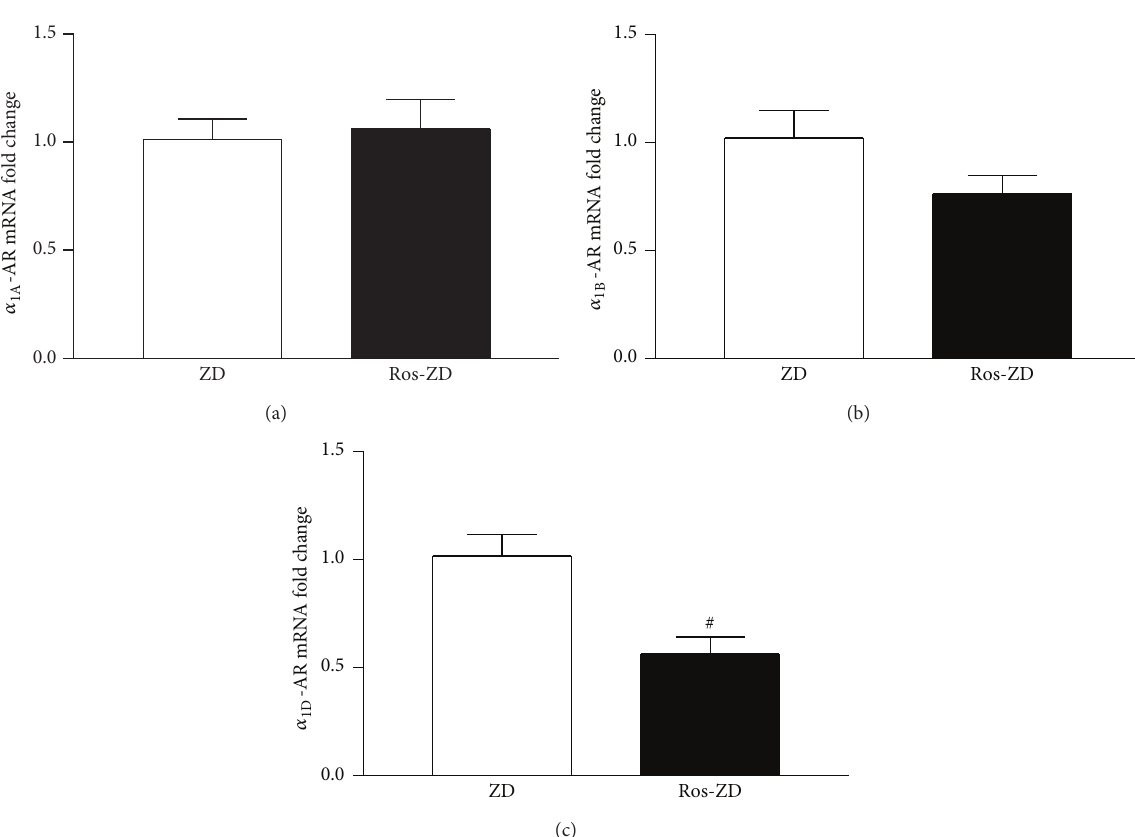
Figure 2: Effect of PPAR 𝛾 activationon renal expression of 𝛼 1 results of renal cortical 𝛼 1 Values are mean ± SEM. 𝑛 = 5 - 6 animals/group. # 𝑃 < 0.05 versus vehicle-treated ZD group.